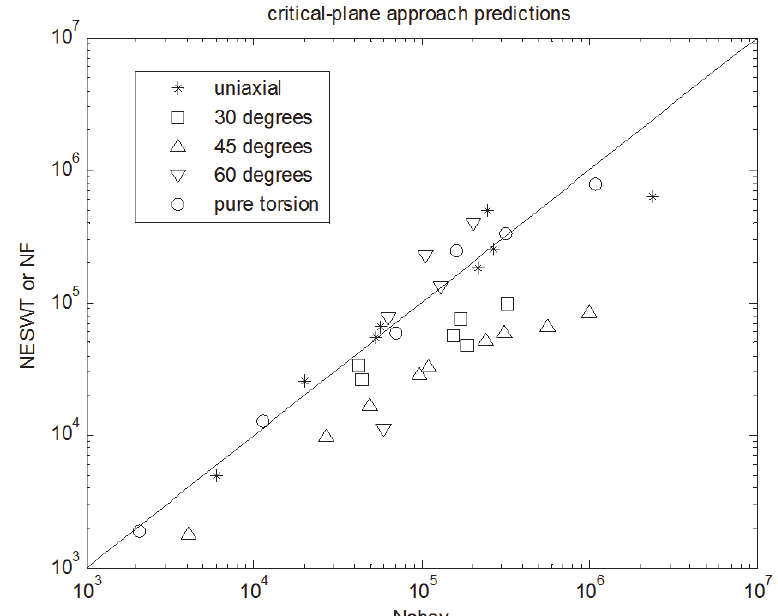
Figure 4: Comparison between the observed lives N obsv and the lives N ESWT or N F predicted by critical-plane methods, according to the dominance of normal or shear applied